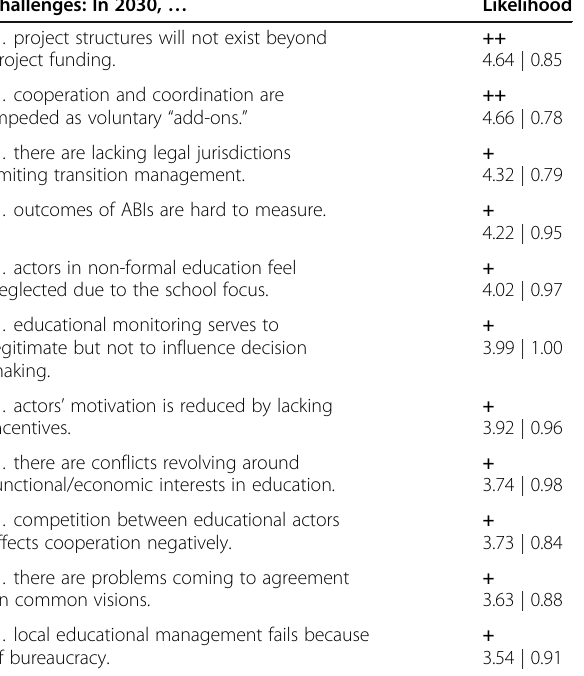
Table 10 Means and standard deviations of ABI challenges Challenges: In 2030, … Likelihood